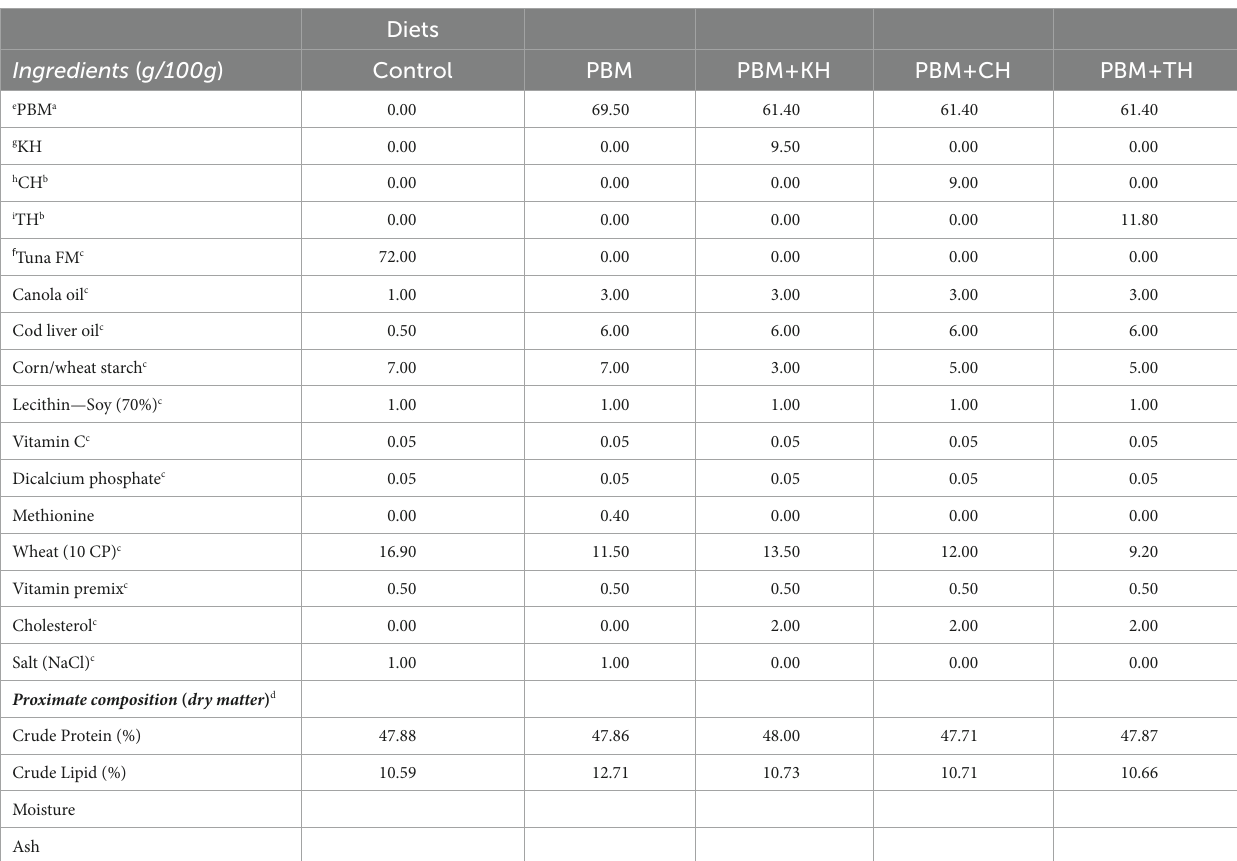
TABLE 1 Feed formulation and nutritional composition of experimental diets from our previous studies (1, 11).